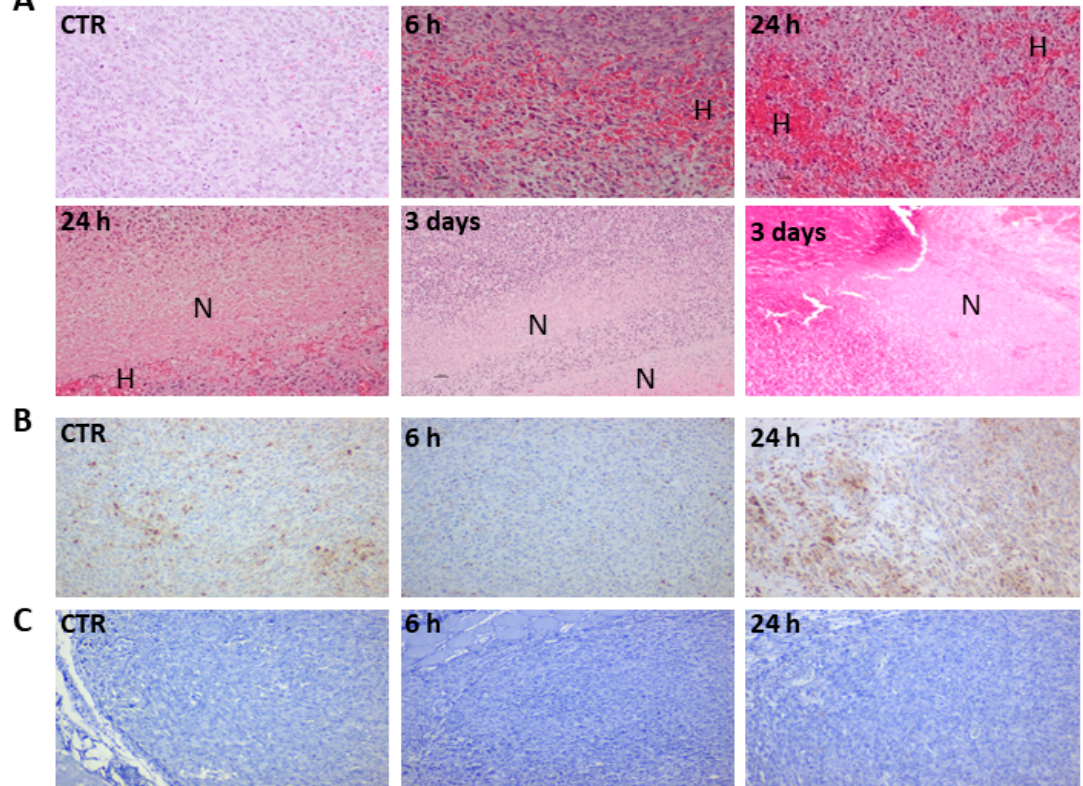
Figure 6. Redaporfin-PDT induces strong haemorrhage and necrosis that is accompanied by T cells infiltration but not by B cells infiltration (10x magnification). ( A ) Tumours from control and treated mice (at the indicated time points) were stained with H and E, H indicates haemorrhagic areas and N indicates necrotic areas. ( B ) T cells (CD3 + ) (brown) infiltration. ( C ) Absence of B cell (Pax5) infiltration.